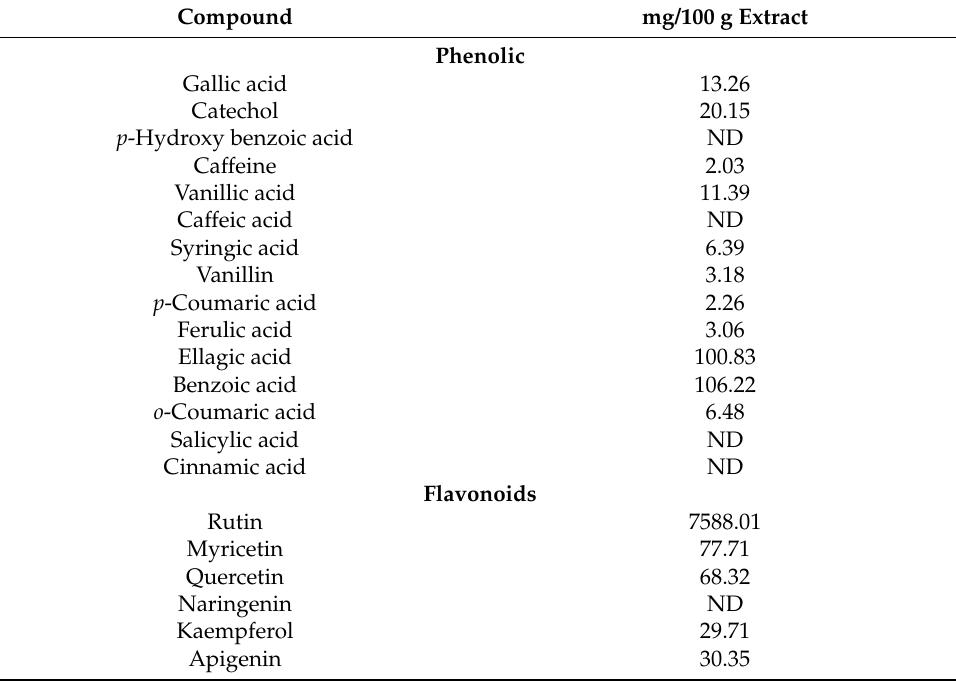
Figure 2. HPLC chromatogram of flavonoid compounds present in clove water extract. Table 1. Chemical composition analysis of phenolic and flavonoid compounds of clove water extract by